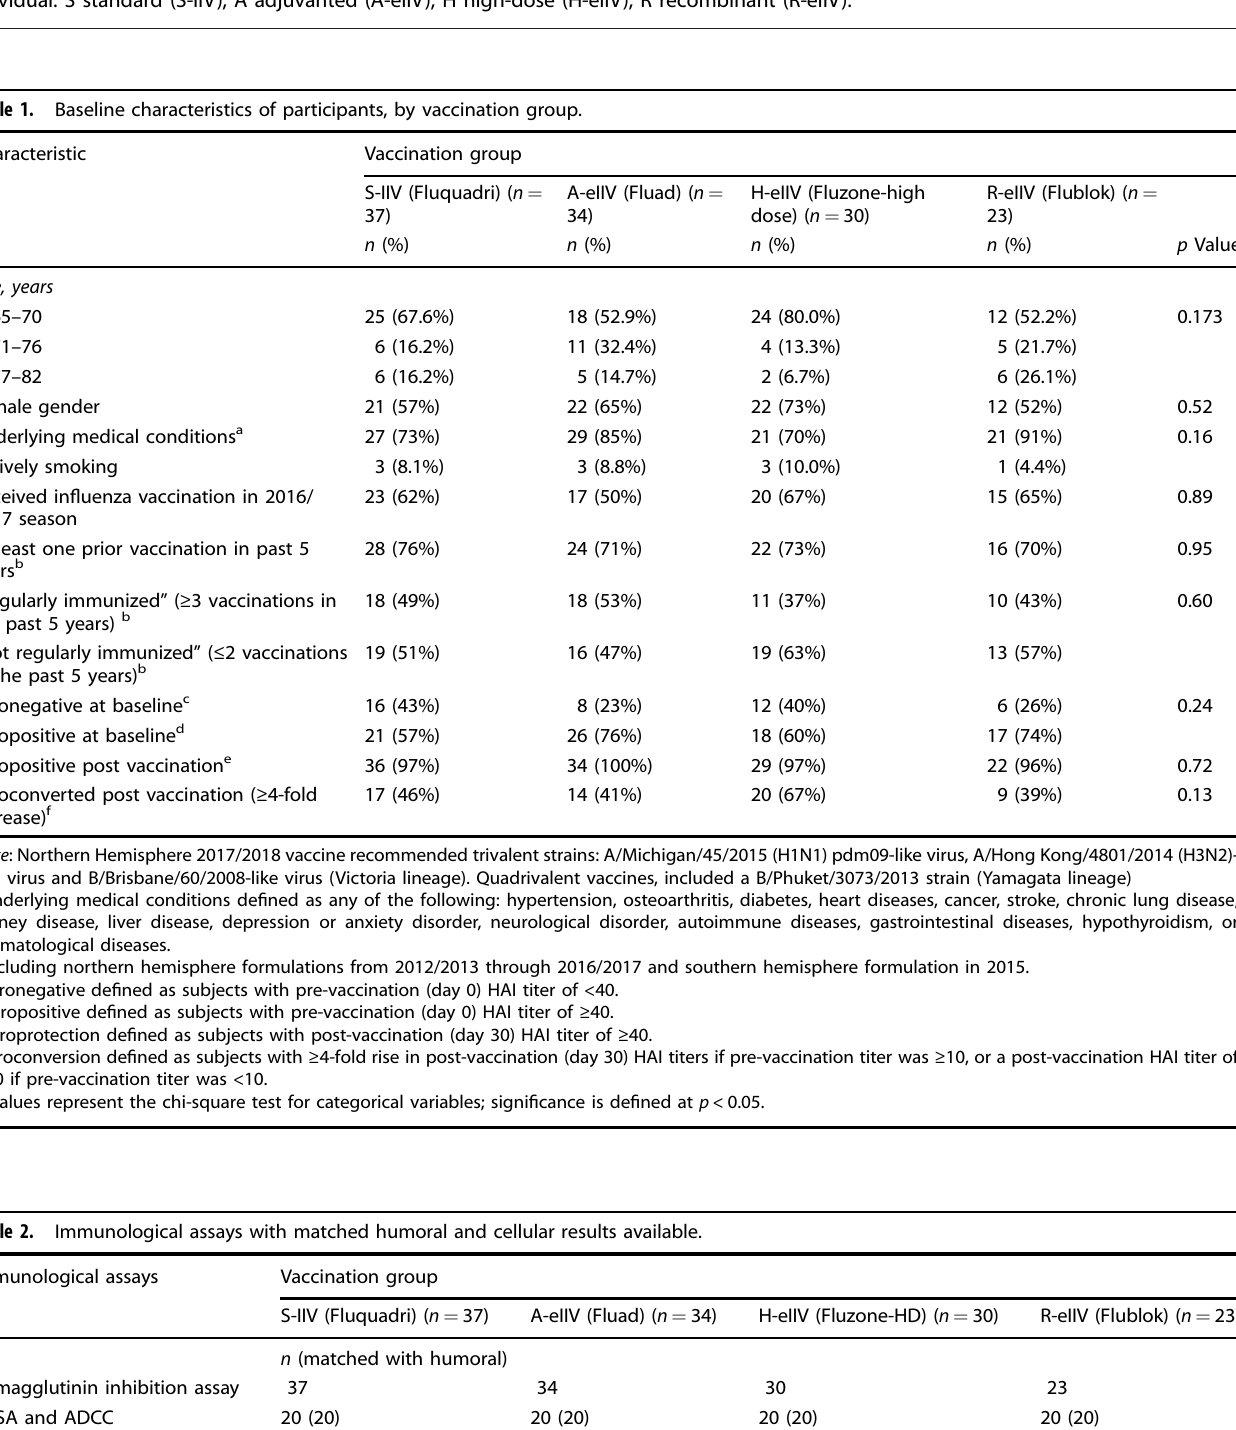
Fig. 1 Analysis of antibody responses against hemagglutinin and G2-stalk proteins. a Subjects were randomized to receive either Fluquadri, Fluad, Fluzone-High-Dose, or Flublok. Serum, plasma, and PBMCs were collected at various time-points. b A(H3N2)-2014 serum HAI antibody titers (S, n = 37; A, n = 34; H, n = 30; R, n = 23). c H3-2013 HA-speci fi c IgG antibody titers ( n = 20 per vaccine group). d Proportion of high-avidity H3-2013 HA-speci fi c IgG. e H3-2013 HA-IgG subclass titers and f ratio between the fold expansion of IgG1 versus IgG3 at day 30 post vaccination. g G2-stalk-speci fi c IgG titers. h Summary heat map depicting mean fold induction of IgG antibody responses from ( b – g ) and H1-2009 HA (from Supplementary Fig. 3a). Wilcoxon signed-ranked test for two-group comparisons. For multiple-group comparisons, Friedman ’ s test for within-group (colored*) and Kruskal – Wallis test for between-group (black*) comparison was performed. * p < 0.05, ** p < 0.01, *** p < 0.001, **** p < 0.0001 versus day 0 or S-IIV, as indicated. Data represented as mean with 95% CI; each dot represents a single individual. S standard (S-IIV), A adjuvanted (A-eIIV), H high-dose (H-eIIV), R recombinant (R-eIIV).